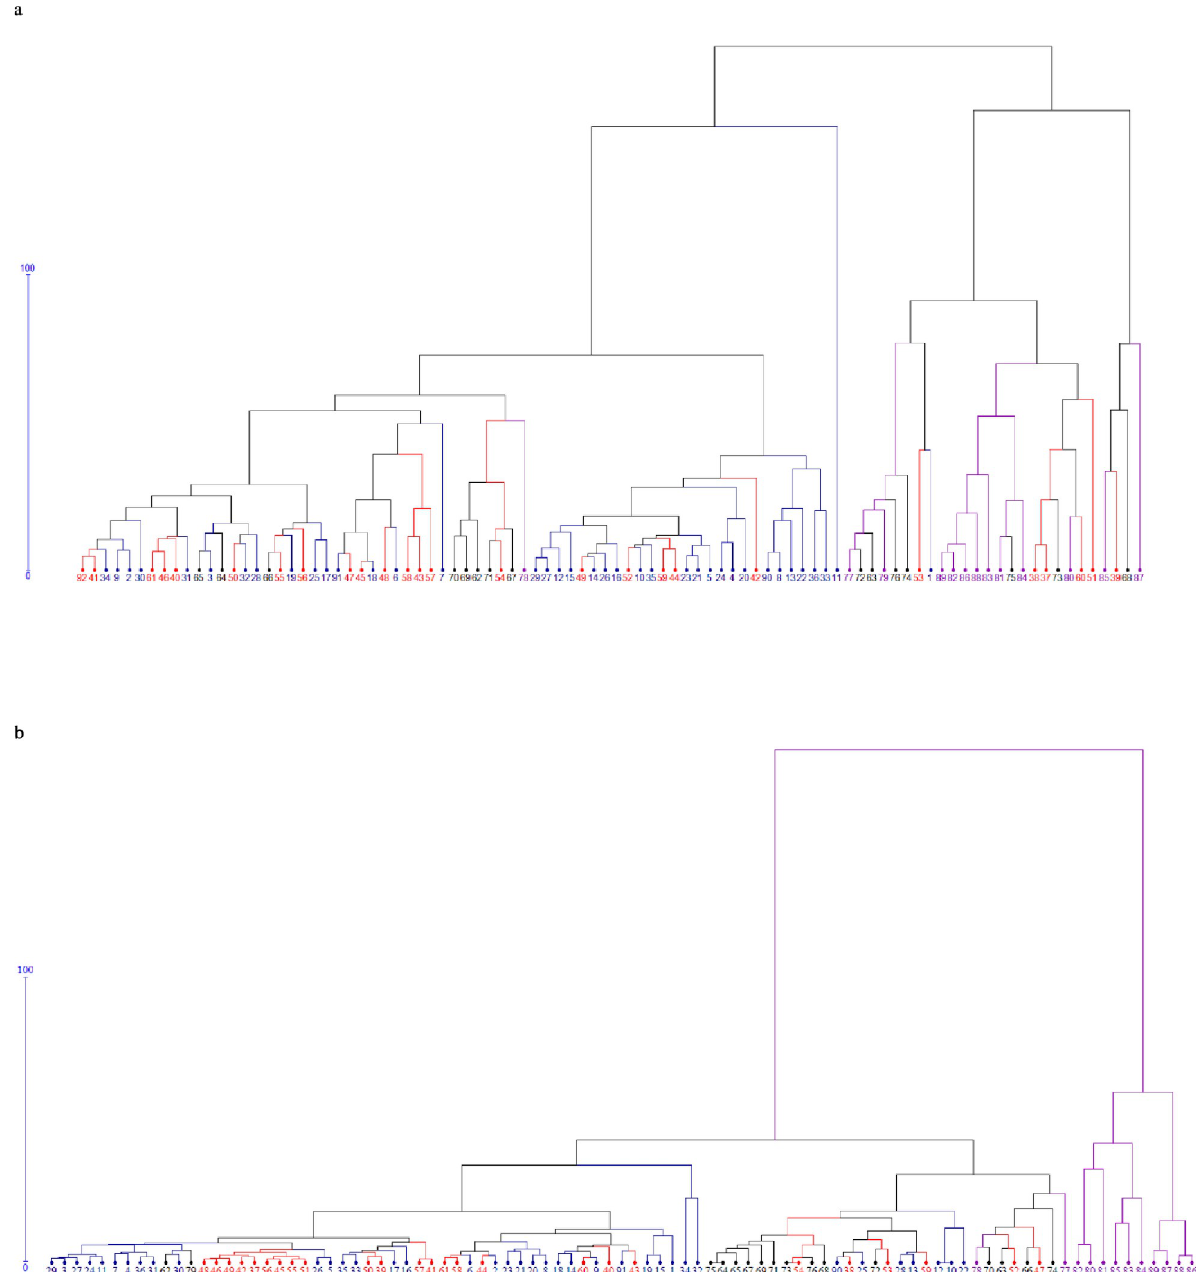
Fig 2. Dendrogram depicting relationship among cauliflower genotypes based on morphological traits observed at Delhi (a) and Barapani (b) centres. Blue- Early, Red- Mid-early, Black- Mid-late, Pink- Late or snowball.